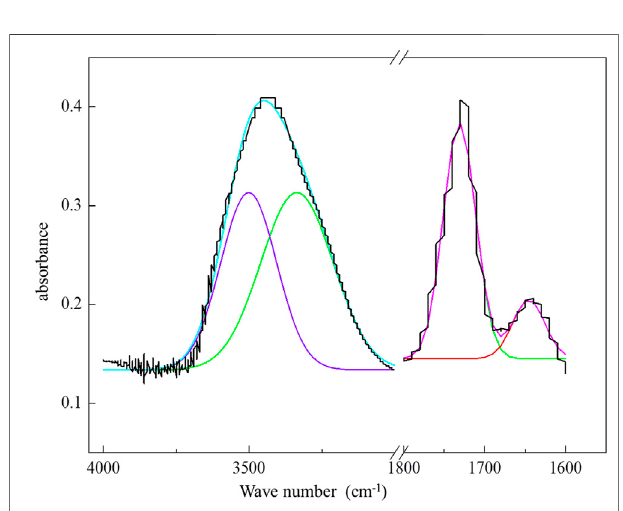
FIGURE 6 | Gaussian fi tting results of DHOPA in the 4,000 – 3,000 and 1800 – 1,600 cm − 1 region.